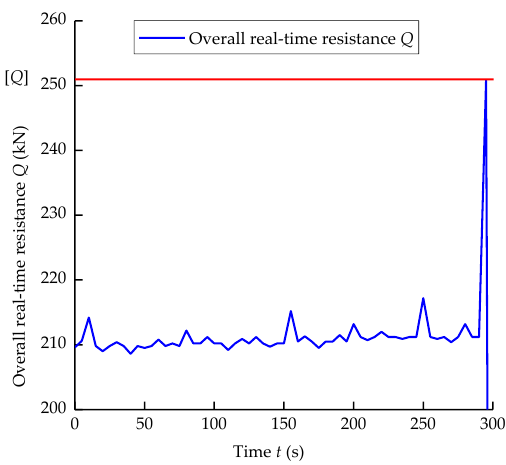
Figure 15. Time-history curve of overall real-time resistance Q (measured by substation S 16 ).